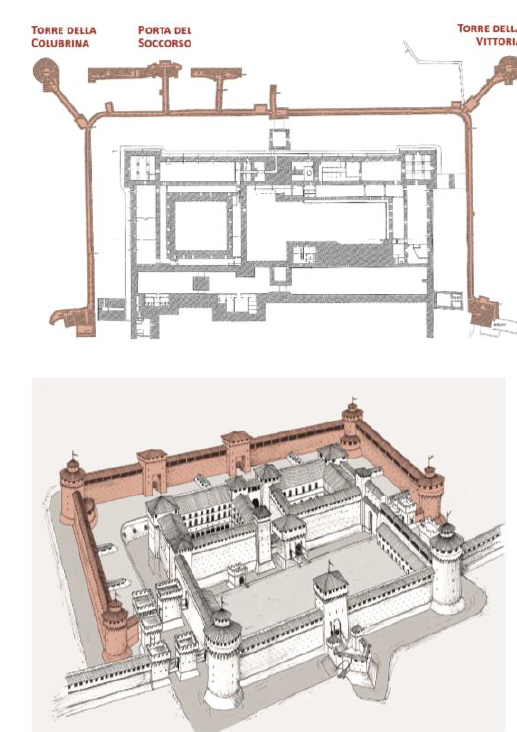
Figure 6. Plan of the Ghirlanda (top) and a reconstruction of its ancient shape (bottom)